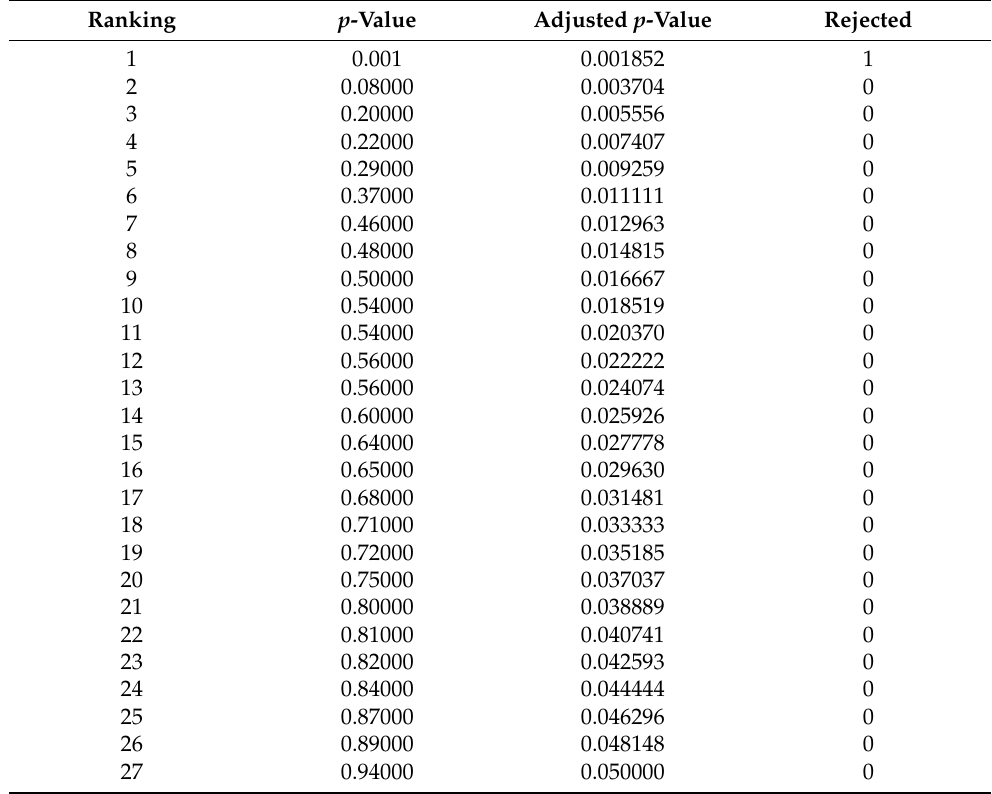
Table A1. Benjamini–Hochberg approach for false discovery rate (FDR) of p -values for all